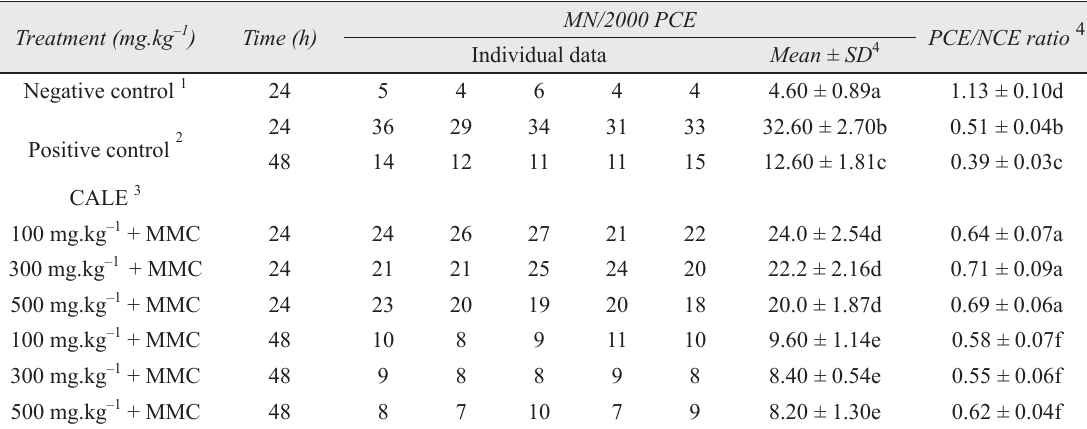
MNPCE frequencies and PCE/NCE ratio after simultaneous treatment with Celtis iguanaea extract (CALE) and mitomycin C